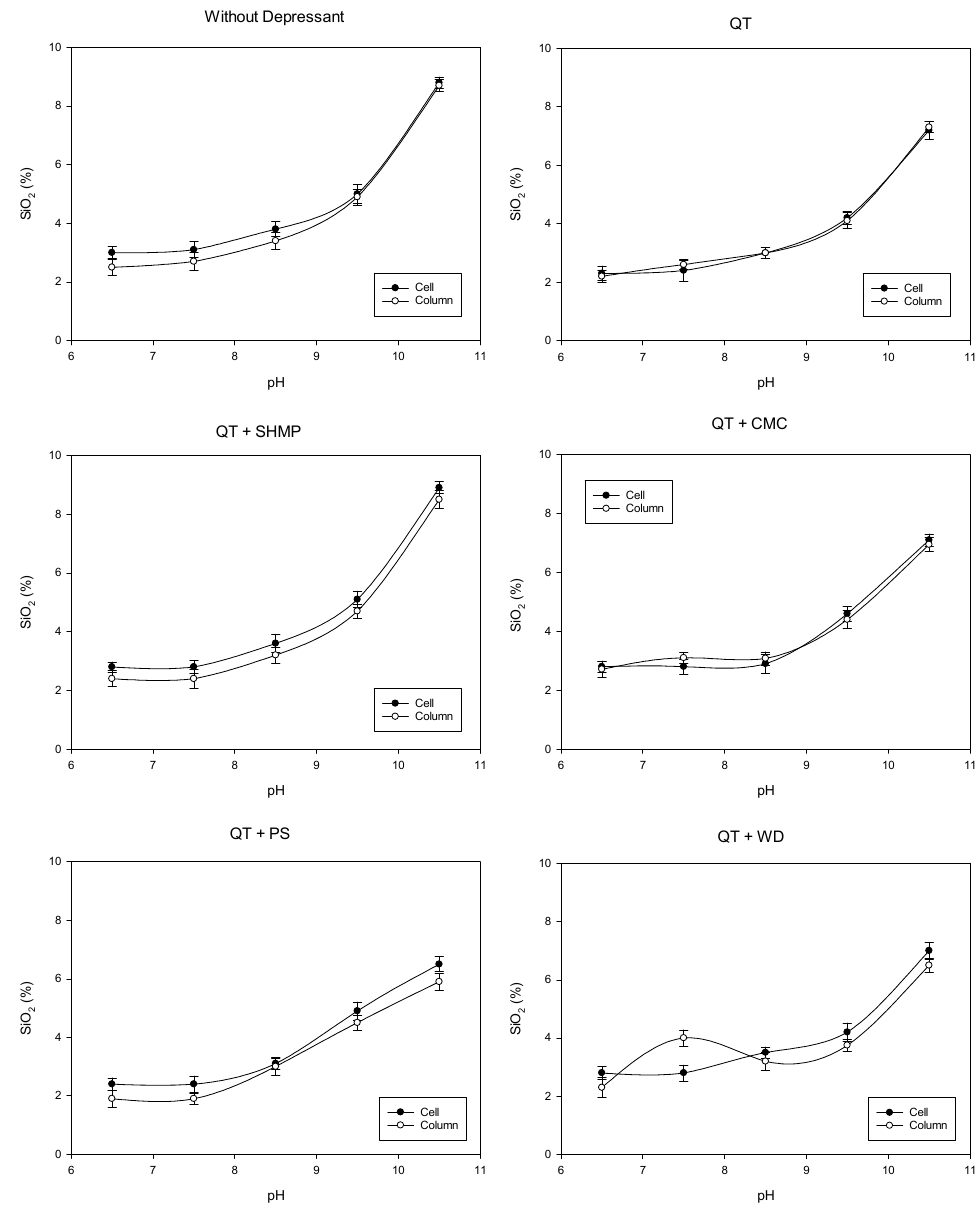
Figure 4. SiO 2 (%) on concentrate for cell and column as pH function and type of depressant.